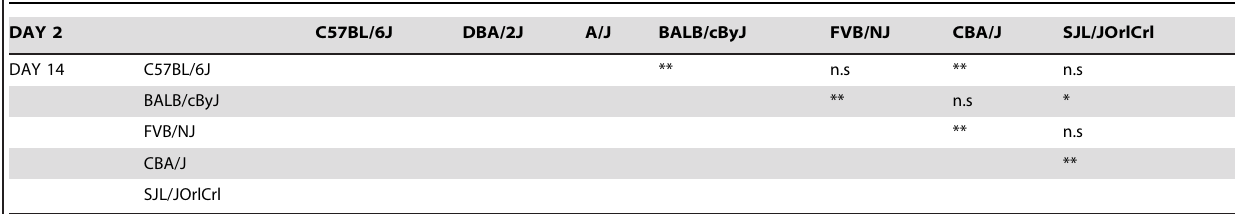
p-values for significance were calculated for all pair wise comparisons between strains and for all days shown in figure 1 using non-parametric Mann-Whitney-U-test. Day 3: the susceptible strain DBA/2J showed significant differences in weight loss compared to the resistant strains C57BL/6J (p , 0.001) and FVB (p , 0.01); the susceptible strain A/J showed significant weight loss compared to all resistant strains (BALB/c: p , 0.01; FVB: p , 0.001; CBA: p , 0.05; SJL: p , 0.01). Days 4, 5, 6, 7: the susceptible strains DBA/2J and A/J showed significant differences in weight loss compared to all resistant strains (in almost all cases with p , 0,001; except for day 6 between DBA/2J and C57BL/6J: p , 0.01). Strain C57BL/6J exhibited significant differences in weight loss compared to the BALB/c mouse strain at days 2–4 (p , 0.001 at days 2 and 3, p , 0.05 at day 4) but not at later time points. On days 6 and 7, FVB differed significantly from all other strains (p-values from , 0.05 to , 0.001). * p value , 0.05. ** p , 0.01.